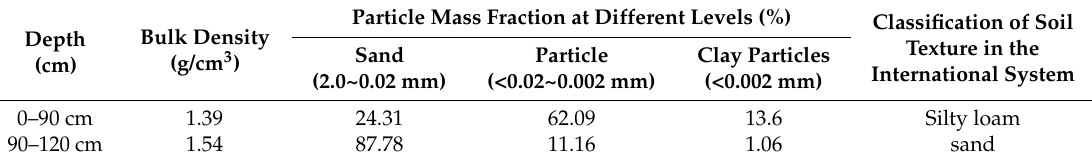
Figure 1. Test area position map. Table 1. The physical properties of the tested soil.